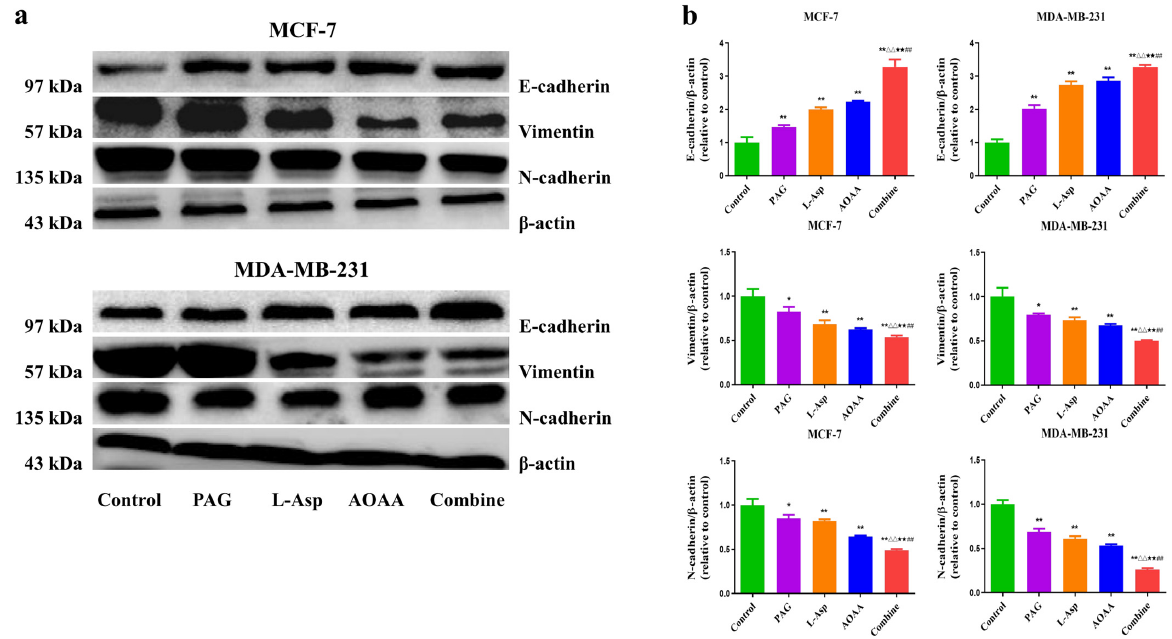
Figure 4. Effects of PAG, AOAA, and L ‐ Asp on the metastasis of ability human BC cells. ( a ) The expression levels of N ‐ Cadherin, N ‐ Cadherin, and Vimentin were detected by Western blot. β‐ actin was used as a loading control. ( b ) Densitometric quantification was performed, normalized to the level of β‐ actin. The experiments were performed in triplicate. Data are presented as mean ± SEM. * p < 0.05, ** p < 0.01 compared with the control group; (cid:52) p < 0.05, (cid:52)(cid:52) p < 0.01 compared with PAG (cid:70) p (cid:70)(cid:70) p group; < 0.05, < 0.01 compared with AOAA group; ## p < 0.01 compared with L-Asp